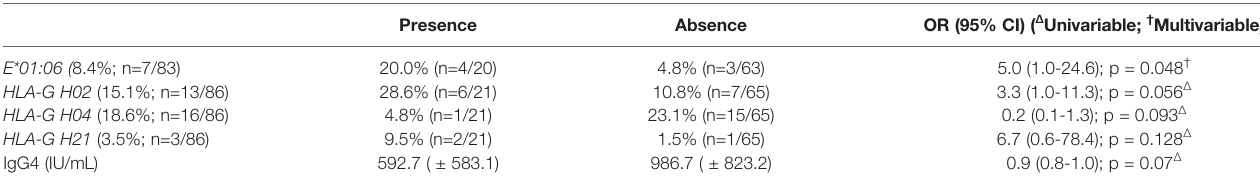
TABLE 2 | HLA class I antibody according to HLA Ib polymorphisms. All samples were included in the analysis, missing genetic data led to the exclusion of the concerned sample from analysis. Presence Absence OR (95% CI) ( Δ Univariable; †